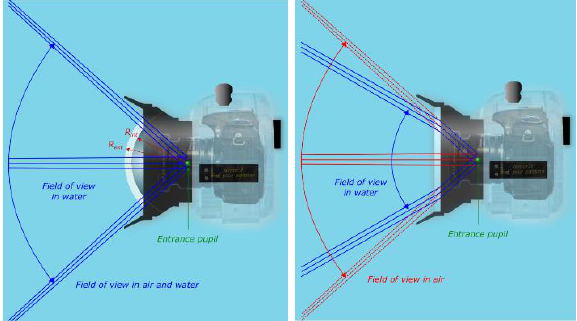
Figure 1. Field of view underwater with dome (left) and flat port